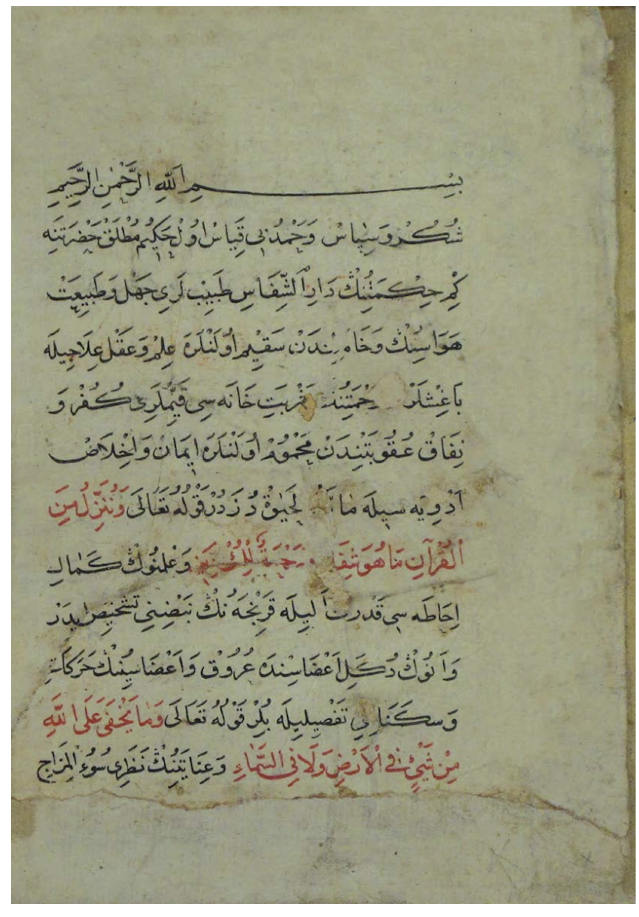
Figure 2. Example page from the manuscript that is investigated in our study.